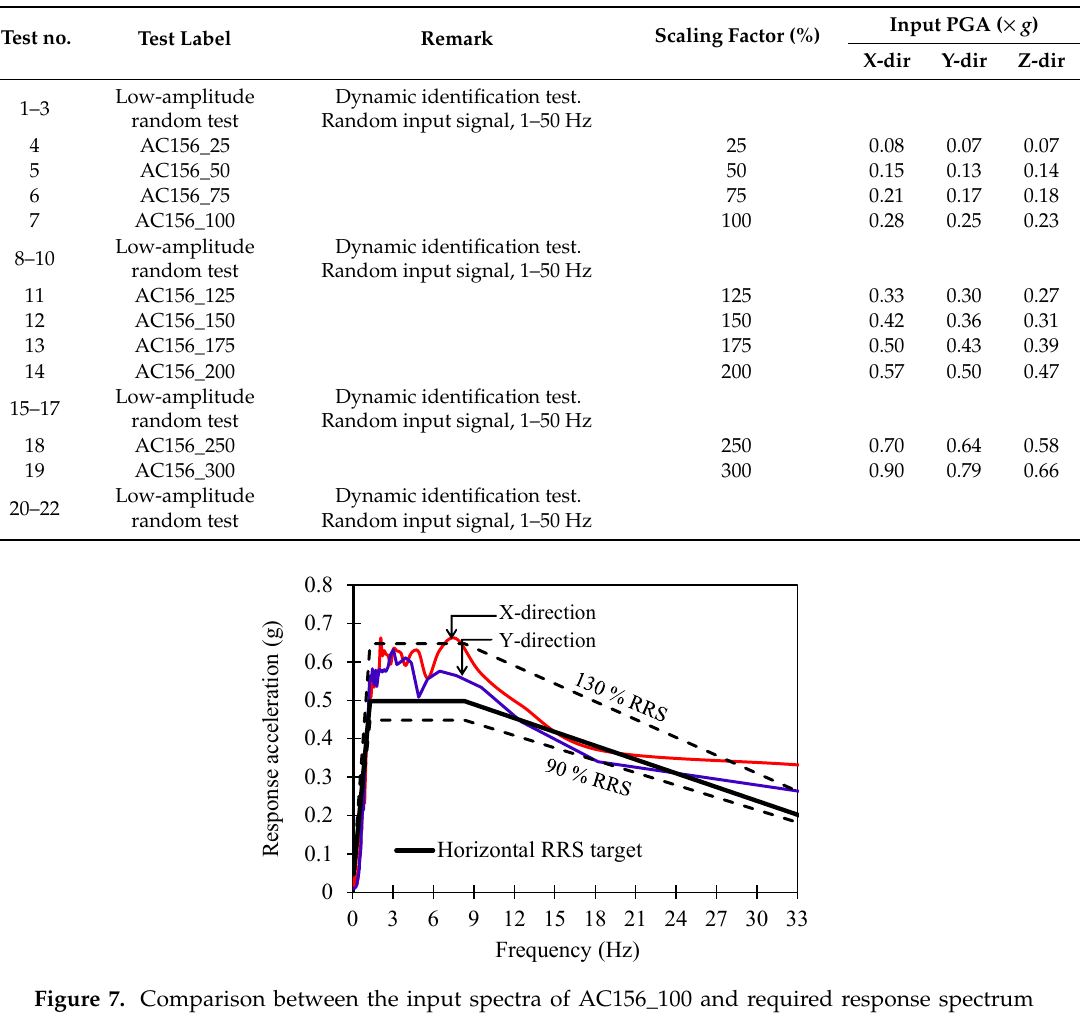
Table 3. Input and test protocol. PGA, peak ground acceleration.